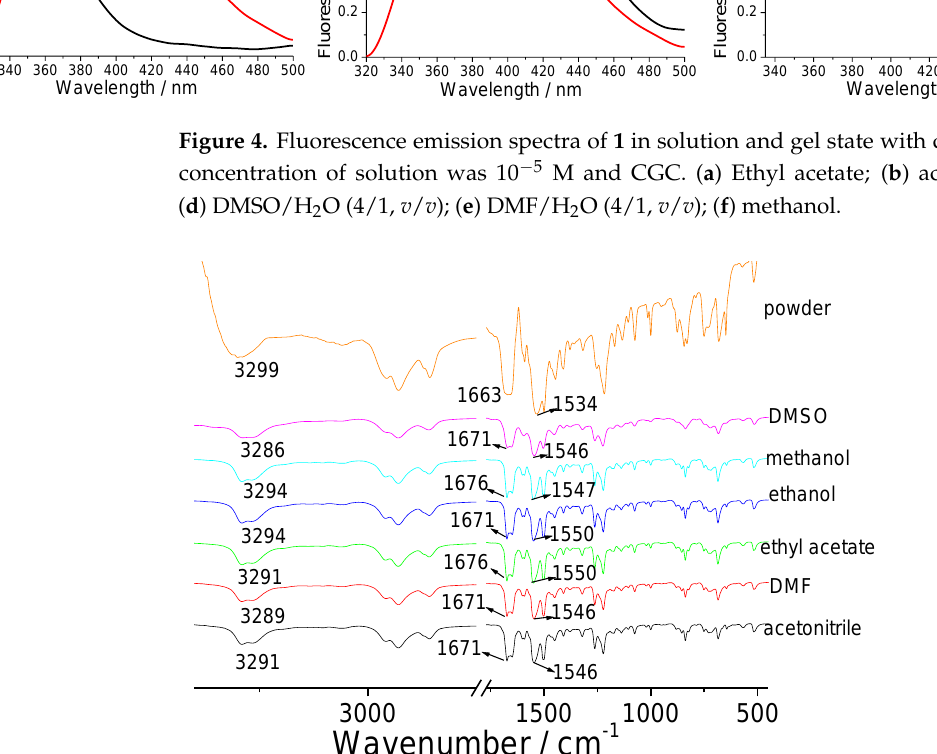
Figure 5. FT IR spectra of xerogels of 1 in different solvents and powder 1 . Surface wettability plays an important role in material application, especially as superhydrophobic and superhydrophilic surfaces have many potential applications [65–67]. The diluted gel of 1 was spread on the glass sheet with a certain thickness to avoid the basal influence, and then dried naturally. As shown in Figure 6a–d, xerogels of 1 in DMF/H 2 O (4/1, v / v ), acetonitrile, DMSO/H 2 O (4/1, v / v ) and ethyl acetate were hydropho- bic with water contact angles of 124°, 131°, 141° and 135°, respectively, whereas xerogels of 1 formed in ethanol and methanol exhibited superhydrophilicity with small contact angles of 80° and 51° (Figure 6e,f). For the above experimental results, it was concluded that the surface wettability of xerogels of 1 was mainly determined by their different self-assembly modes and structures due to their same components. Figure 6. Imaging of water contact angle of xerogels of 1 coated with different solvents. ( a ) DMF/H 2 O (4/1, v / v ); ( b ) acetonitrile; ( c ) DMSO/H 2 O (4/1, v / v ); ( d ) ethyl acetate; ( e ) ethanol; ( f ) methanol. To further verify the AIE of gelator 1 , the fluorescence emissions of gelator 1 in the solution and gel state with different water proportions were obtained (Figure 7). With water content up to 70%, the emission of solution 1 in acetonitrile was greatly enhanced by 75 times, and then was decreased after the water content was more than 70% (Figure 7a). The fluorescence emission change of solution 1 in acetonitrile with different contents of water was well verified by the corresponding images (Figure S2). It was regrettable that the emission light from solution 1 with 70% water was not observed under a portable UV lamp. A similar emission change was observed in the gel system (Figure 7b). When the water proportion increased from 1/100,000 to 1/1000, the fluorescence intensity of the gel of 1 also continuously increased. If the water proportion was more than 1/1000, the